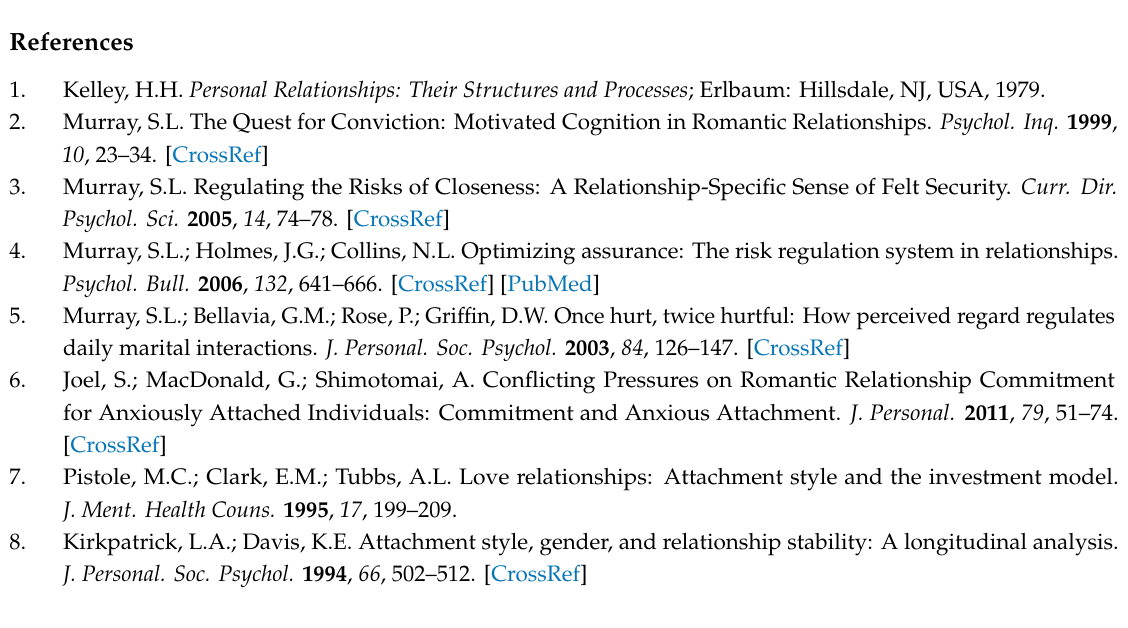
Table S1: Integrated data analyses: the e ff ects of actor and partner daily felt security on actors’ daily commitment, Table S2: Integrated data analysis: the e ff ects of actor and partner attachment anxiety on actors’ daily commitment, Table S3: The e ff ects of actor and partner daily felt security and actor and partner attachment anxiety on actors’ daily commitment, Table S4: The e ff ects of actor and partner attachment avoidance on actors’ daily commitment, Table S5: The e ff ects of actor and partner attachment anxiety and actor and partner attachment avoidance on actors’ daily